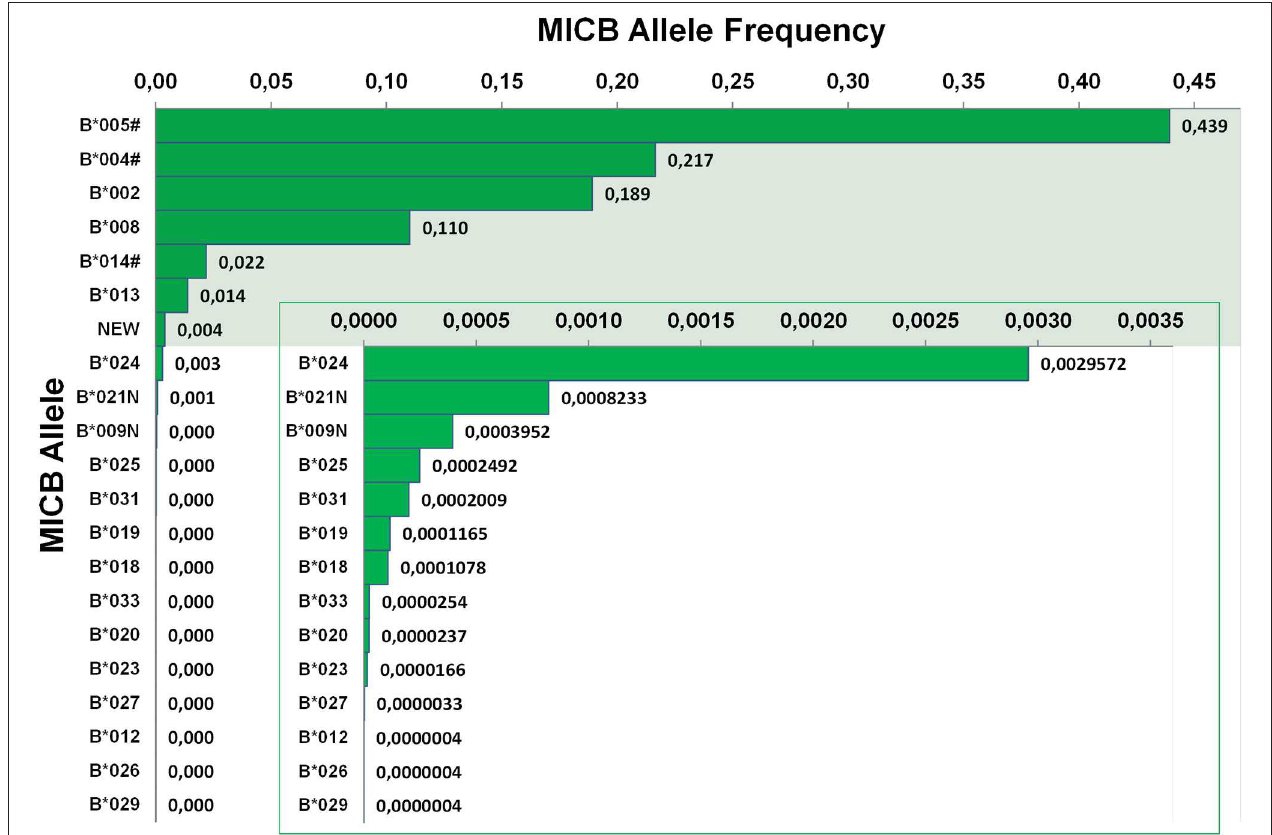
FIGURE 3 | Allele frequencies of MICB . First-field-resolution allele frequencies are based on 1,201,896 samples from donors of German descent. Alleles contributing to a cumulative allele frequency of 99.5% are shown against a colored background and allele frequencies below 0.004 are additionally plotted in an inlay. If ambiguities exist, allele groups are used (#) and the ambiguity is described in Table 1